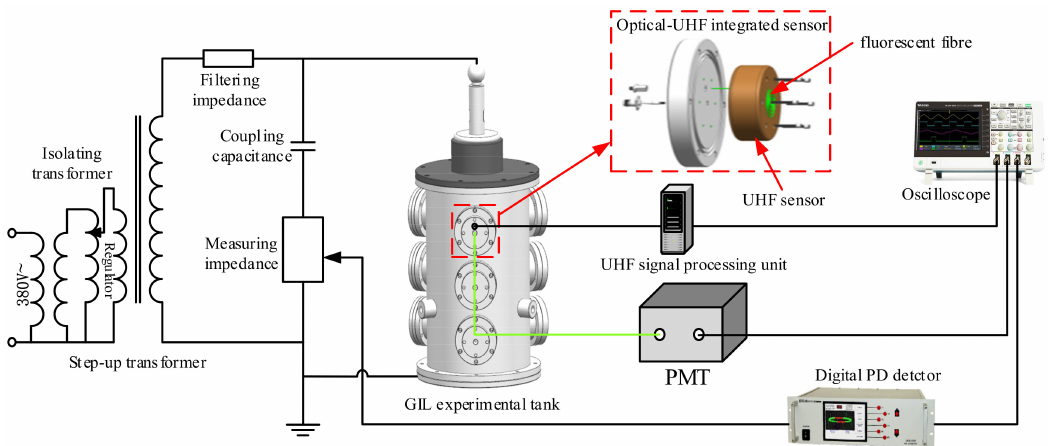
Figure 1. Partial discharge (PD) detection platform of gas-insulated transmission lines (GIL).